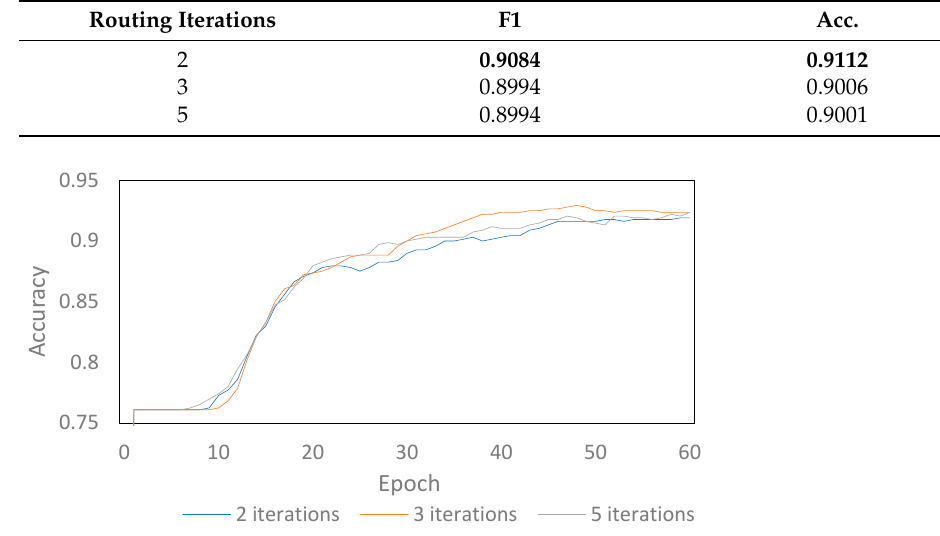
Figure 7. Influence of routing iterations on the proposed U-IntentCapsNet model. Table 17. Intent detection results by varying routing iterations in the proposed U-IntentCapsNet model.